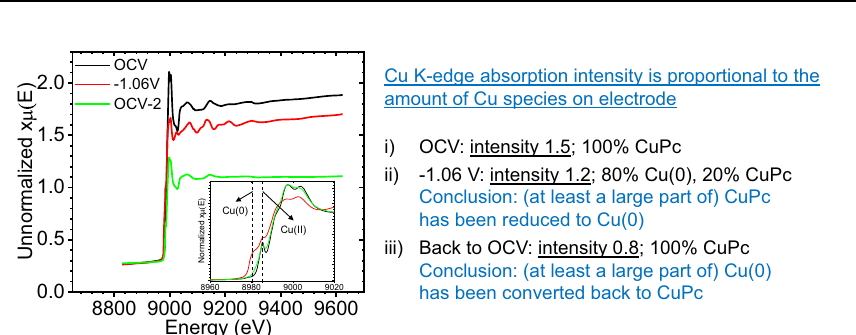
Table 1 Original conclusions of the article and key points raised by RB ’ s MA. Our original conclusions RB ’ s MA At reductive potential ( − 1.06 V), CuPc is reduced to Cu NPs which are the active catalyst for CO 2 reduction to CH 4 .